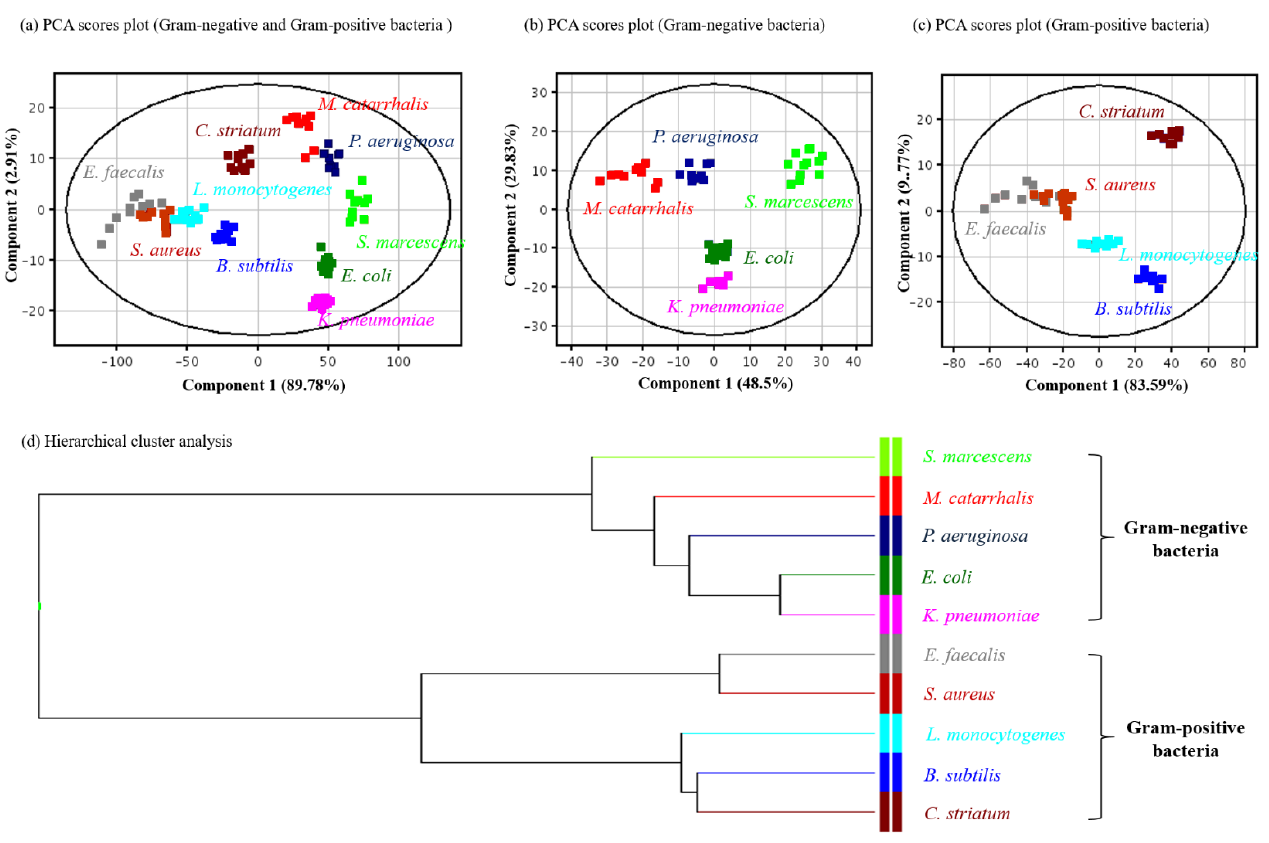
Figure 5. The PCA scores plots ( a – c ) and HCA ( d ) of the lipid ion signals on the TD-ESI mass spectra of extracts from 10 bacterial species. Each colony was determined by 10 measurements.